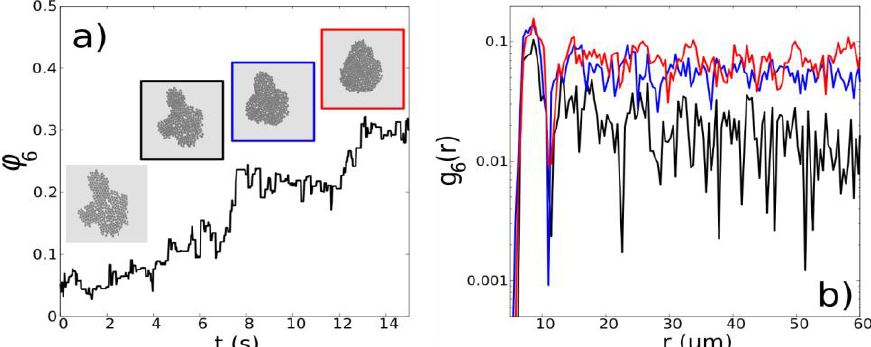
Figure 5. ( a ) Time evolution of 𝜑 6 (𝑡) along the Brownian dynamics simulation, during the application of three different pulses, alongside snapshots representing the system at the beginning of the simulations, at 4 s (black), 9 s (blue) and 14 s (red). ( b ) Hexagonal order correlation function for the following three different times: 4 s (black), 9 s (blue) and 14 s (red) that correspond with the snapshots of the system shown in panel ( a ). The simulation has been run for 𝜏 𝑝 = 0.15 s , 𝜇 0 𝐻 𝑡𝑜𝑡𝑎𝑙𝑒𝑥𝑡 = 5.5 mT , 𝜇 0 𝐻 0 = 3 mT , 𝑇 = 2𝜋/𝜔 𝑝𝑢𝑙𝑠𝑒 = 5 s , 𝑓 𝑥 = 20 Hz and 𝑓 𝑦 = 60 Hz .